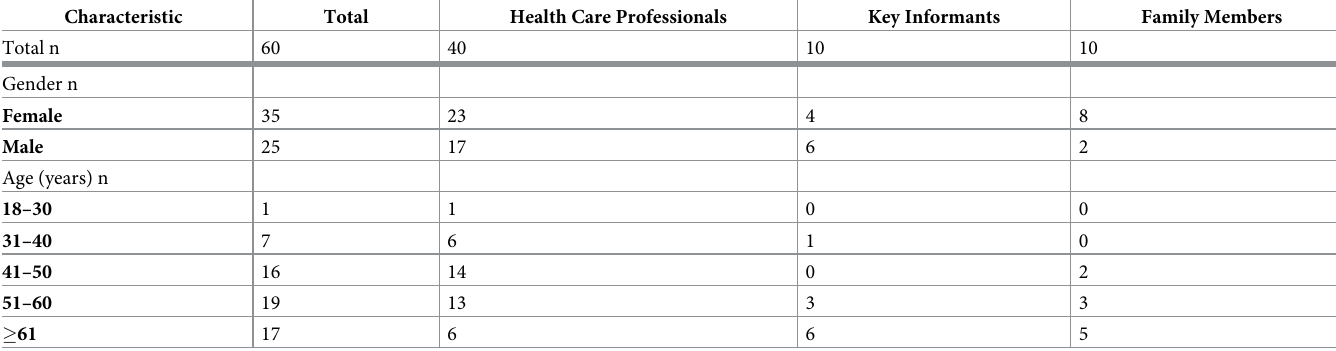
Table 1. Participants’